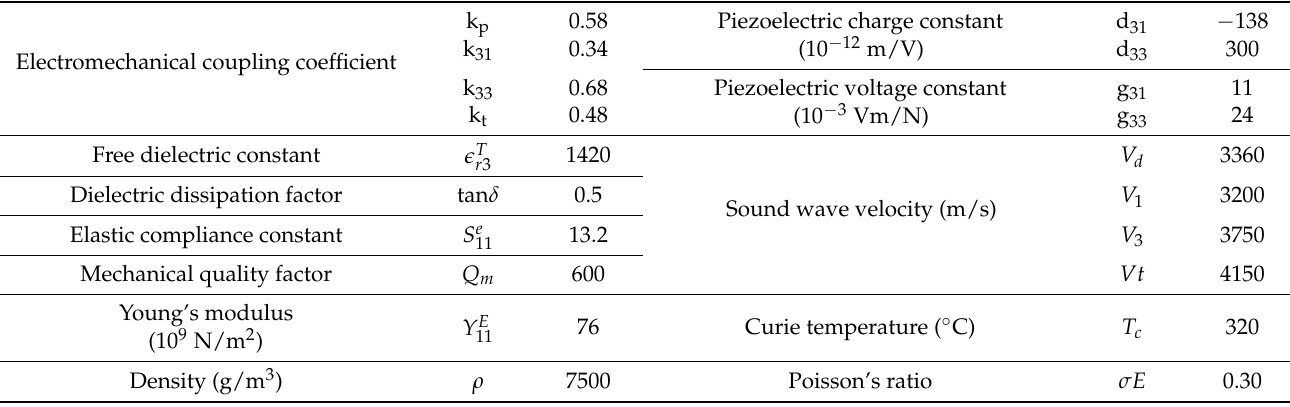
Electromechanical coupling Table 2. Material properties of PZT-43 used for the PZT hemispherical hydrophone.